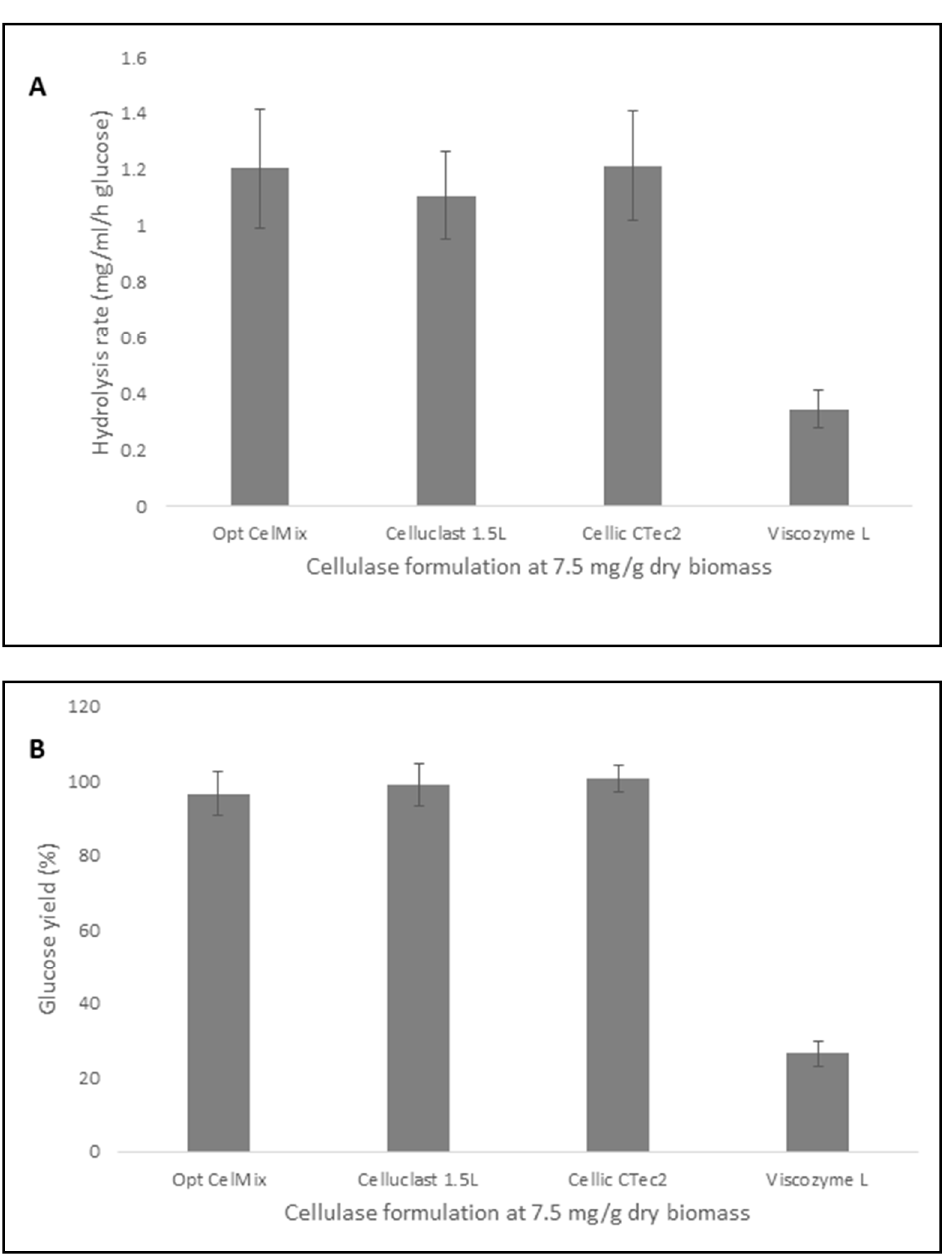
Figure 7. Comparison of ( A ) hydrolytic rates after 6 h and ( B ) glucose yields obtained after 48 h from the hydrolysis of 2% ( w / v , dry mass basis) paper sludge for 48 h at 50 °C using the Opt CelMix, Celluclast ® 1.5 L, Cellic ® CTec2 and Viscozyme ® L at a protein loading of 7.5 mg/g biomass. All experiments were performed in quadruplicate, and the mean values and error bars (±SD) were calculated. The statistical analysis showed that the differences were statistically significant (one-way ANOVA, p < 0.05).